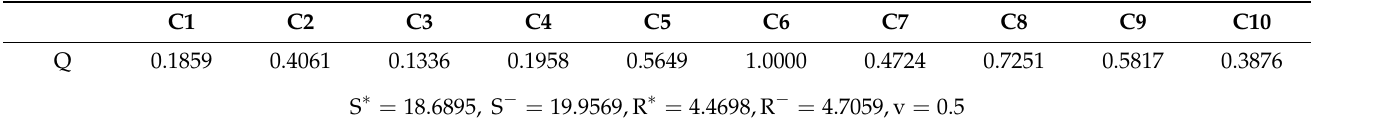
Table 19. The calculation results of Q j .